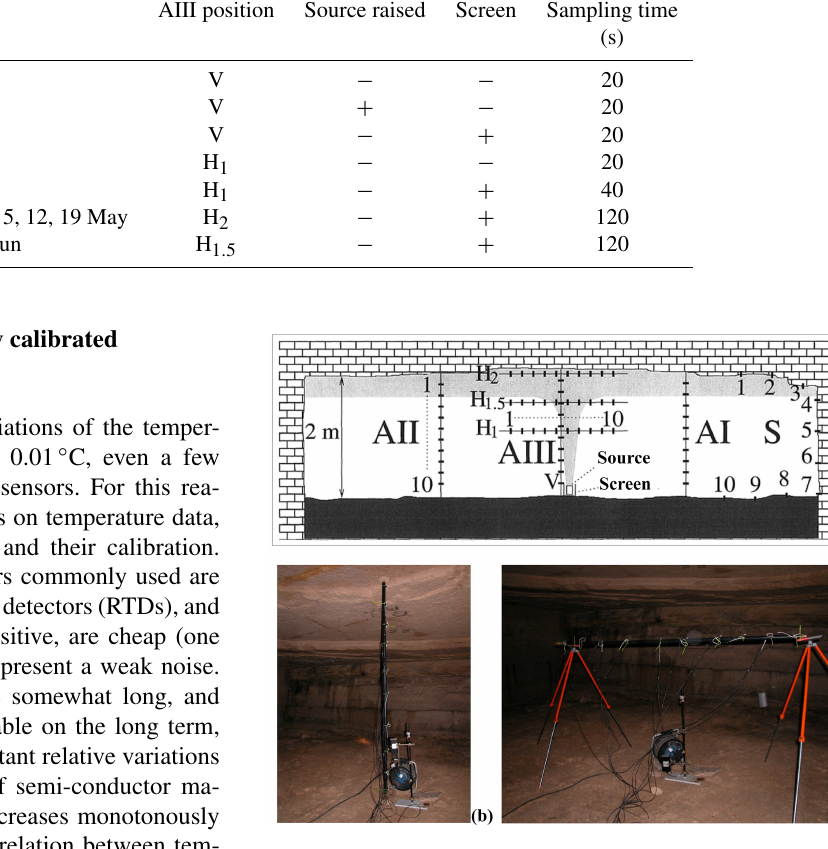
Figure 2. (a) Schematic cross section of the experimental room S15 showing the four setups (AI, AII, AIII, and S) along with the posi- tions of the temperature sensors (1–10 for each set-up); (b, c) photos of the setup AIII in advance of the heating experiments A2 and A4 (Table